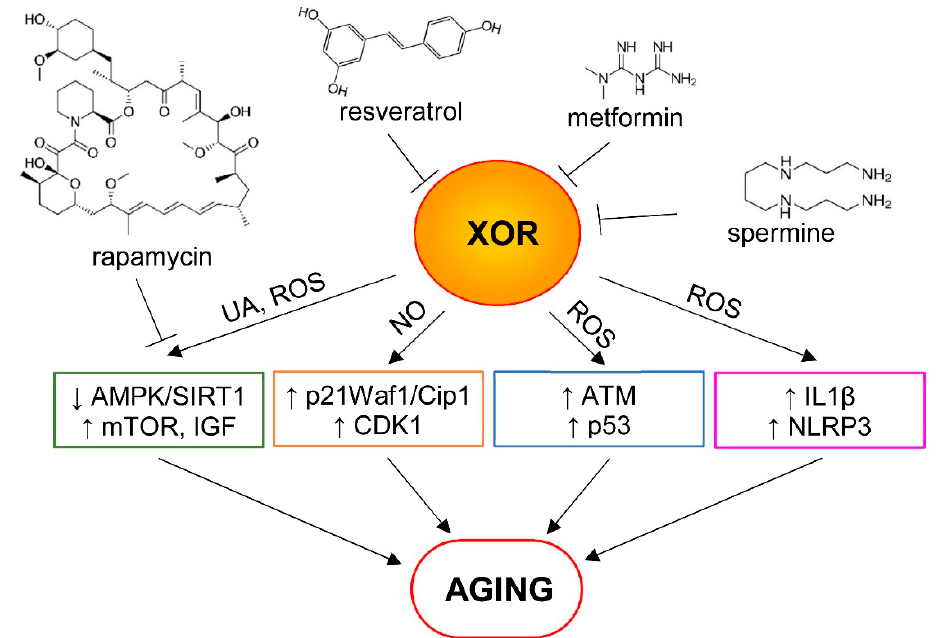
Figure 3. Some proposed mechanisms of aging involving xanthine oxidoreductase (XOR) and its products. Uric acid (UA) and reactive oxygen species (ROS) can play a role in the downregulation of AMP-activated protein kinase/sirtuin-1 (AMPK/SIRT1) levels and in the upregulation of the mTOR and insulin/insulin-like growth factor (IGF) pathways. Nitric oxide (NO) produced by XOR nitrite reductase activity can inhibit cell proliferation, activating p21Waf1/Cip1 signaling and increasing the cyclin-dependent kinase 1 (CDK1) protein level. In addition, XOR-derived ROS can activate the ataxia telangiectasia mutated (ATM) enzyme, which upregulates p53, and causes IL1 β release, as well as NLRP3 inflammasome activation and inflamm-aging. Pro-aging effects of XOR can be reduced by some pharmacological agents that inhibit the mTOR pathway (e.g., rapamycin) or interfere with XOR activity (e.g., resveratrol, metformin and spermine), as described in the text.